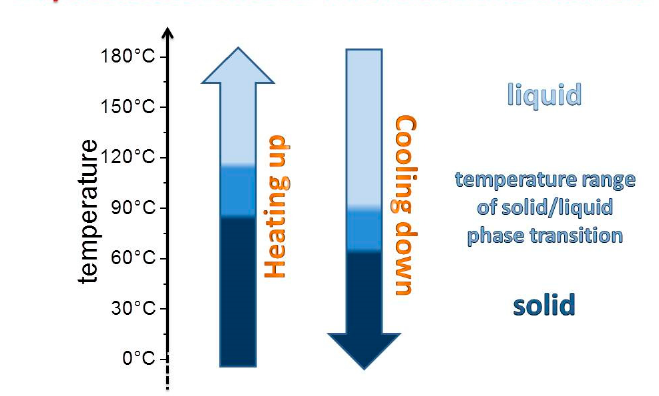
Figure 2. Phase transition mechanism of Sasobit in bitumen binder.